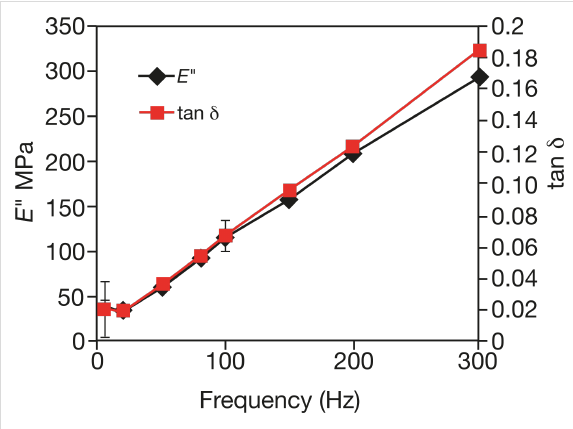
Figure 9: Dynamic AFM measurements of iPP as a function of the frequency. The measurements were made at a depth h = 50 nm by using a probe with a spring constant k = 33 N/m and a nominal tip radius of 50 nm. The oscillation amplitude was maintained at 10 nm.